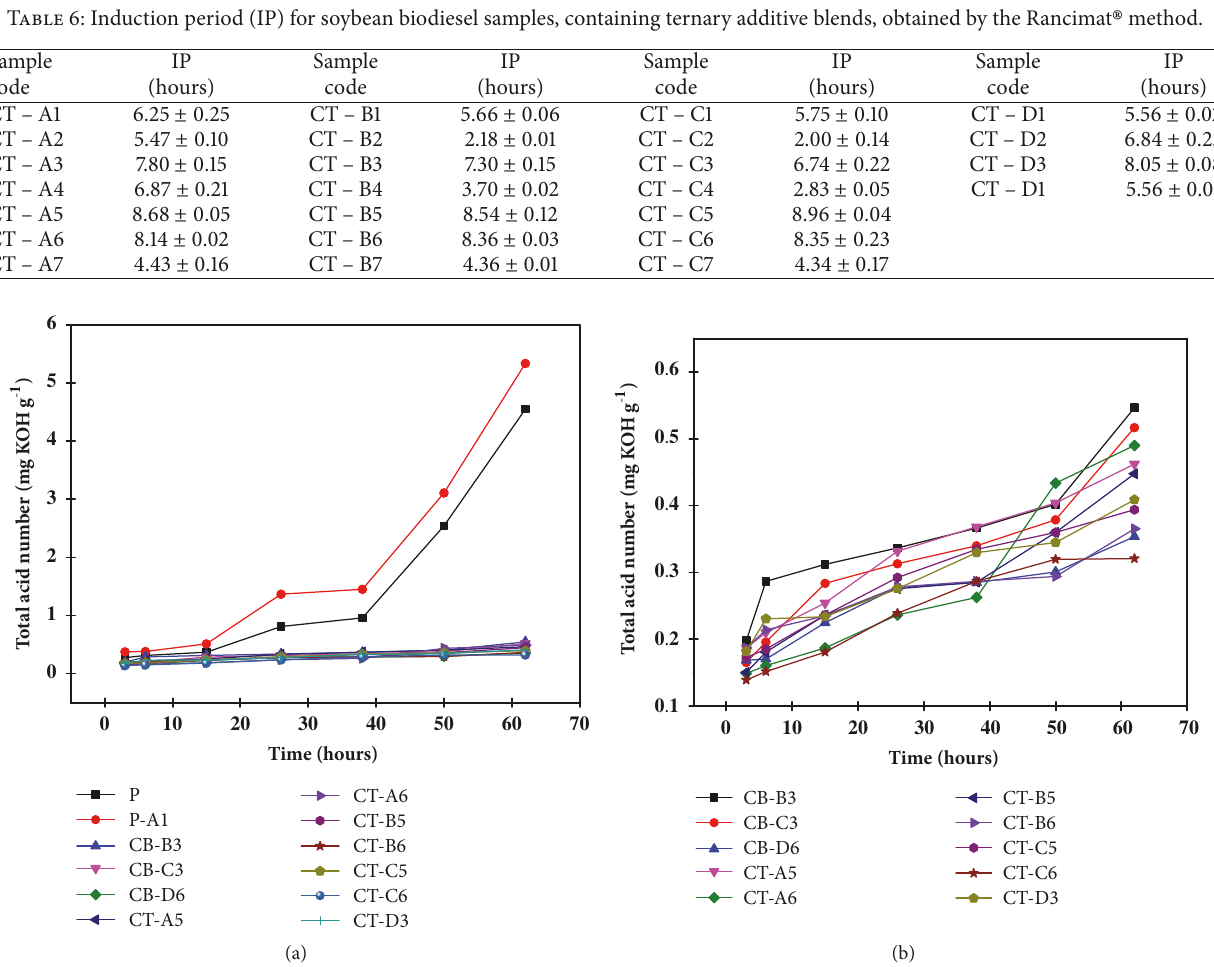
Figure 2: Total acid number of some selected representative samples heated at 85 ∘ C as a function of the heating time. (a) Selected representative samples. (b) Binary and ternary blends among the selected representative